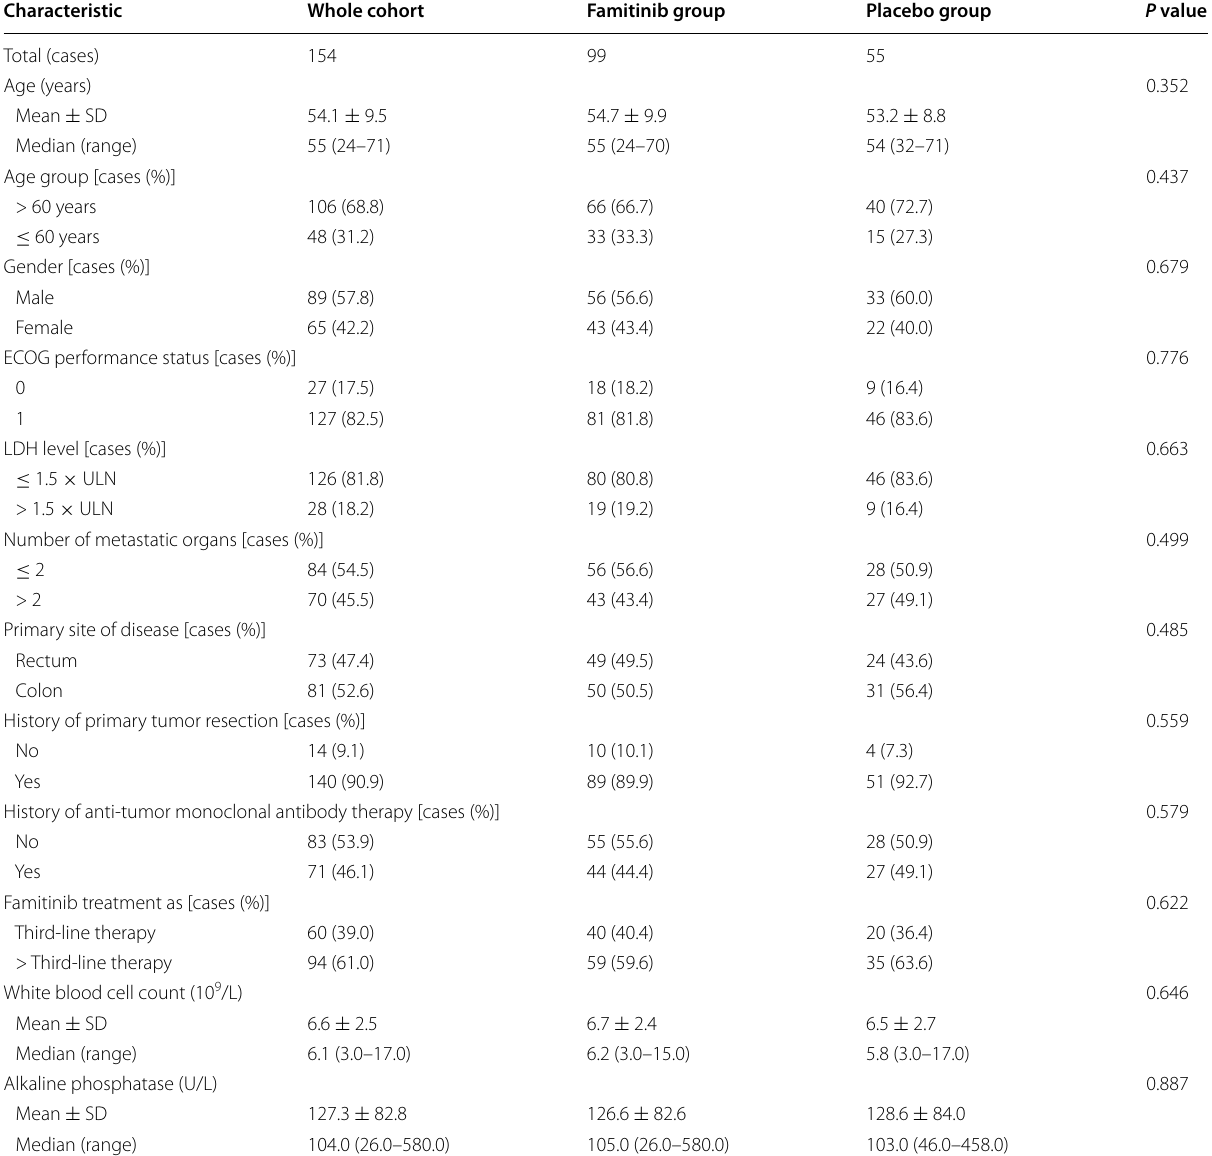
Table 1 Baseline characteristics of patients with metastatic colorectal cancer (mCRC) who were treated with famitinib or placebo in the full analysis